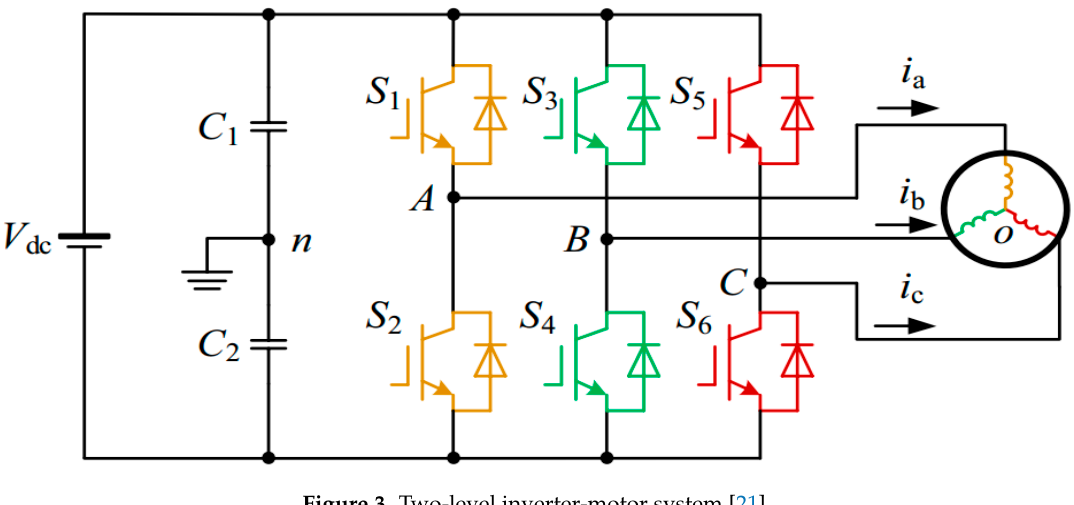
Figure 3. Two-level inverter-motor system [21] .